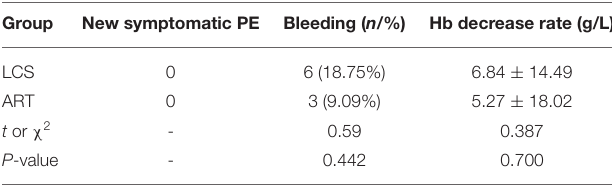
TABLE 4 | Comparison of the incidence of complications in the two treatment methods.